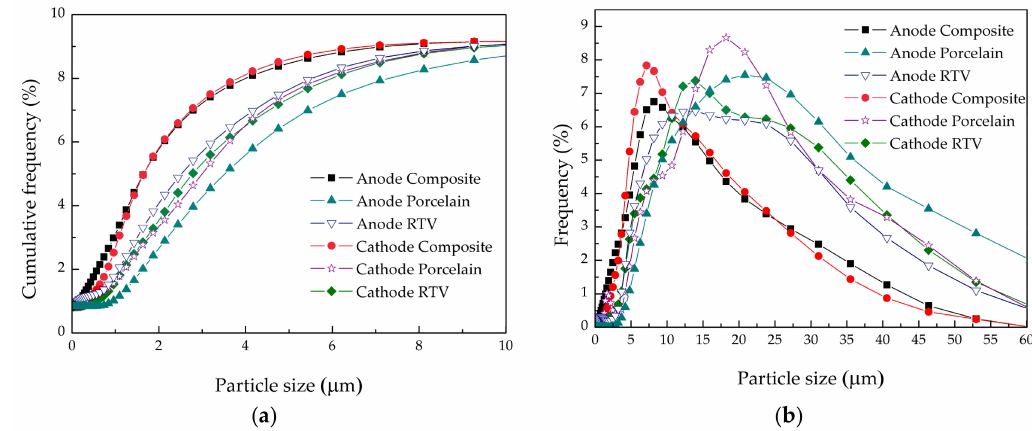
Figure 10. Contamination particle size. ( a ) The cumulative frequency of the particle size; ( b ) The frequency of the particle